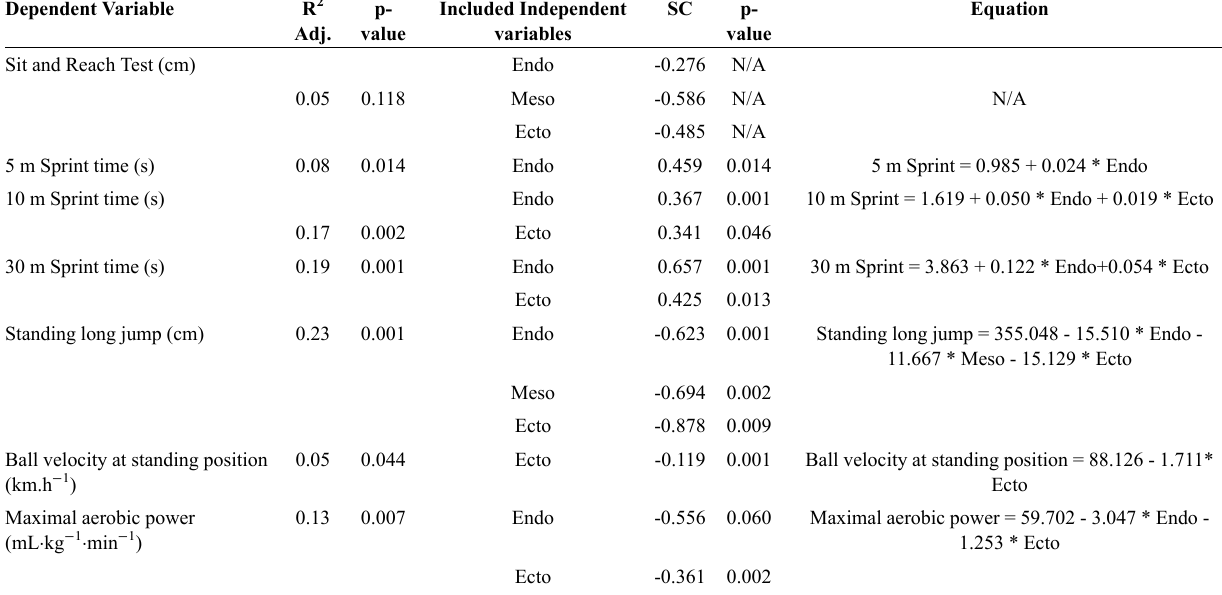
Table 4 - Regression results for different performance models.